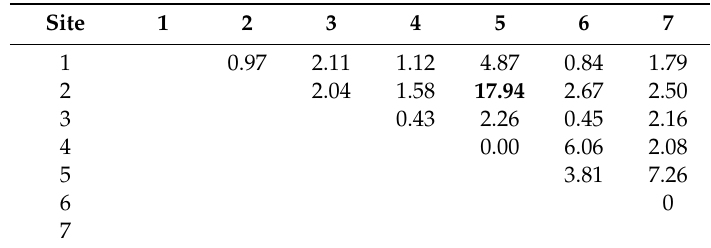
Table 4. Similarity matrix for the species richness in studied sites of the bogs of the Ershov oil field in the Vakh River basin of the KMAO-Yugra. Highest coe ffi cient of similarity is marked by bold.